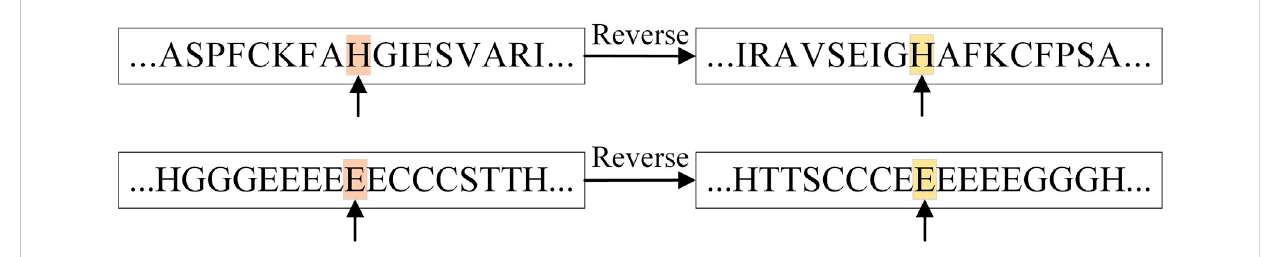
FIGURE 8 Reverse representation of amino acid and secondary structure